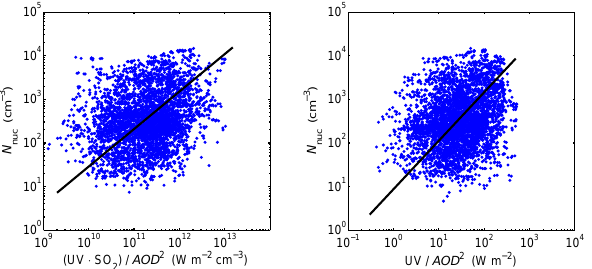
Fig. 2. Same as Fig. 1, but with CS replaced with AOD. Left: log( y) = 0 . 86 × log( x) − 7 . 141 ( r = 0 . 25, p < 0 . 001); Right: log( y) = 1 . 11 × log( x) + 0 . 94 ( r = 0 . 23, p < 0 . 001).